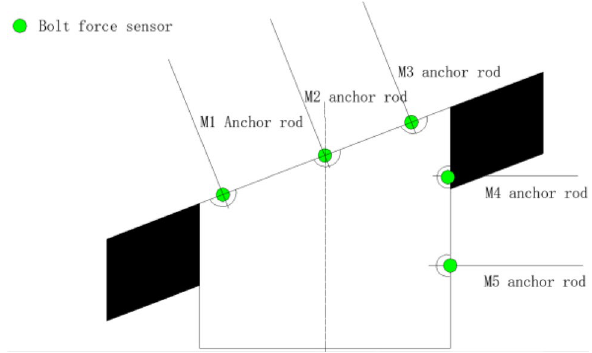
Figure 7. Distribution of anchor bolt and anchor bolt force sensor.